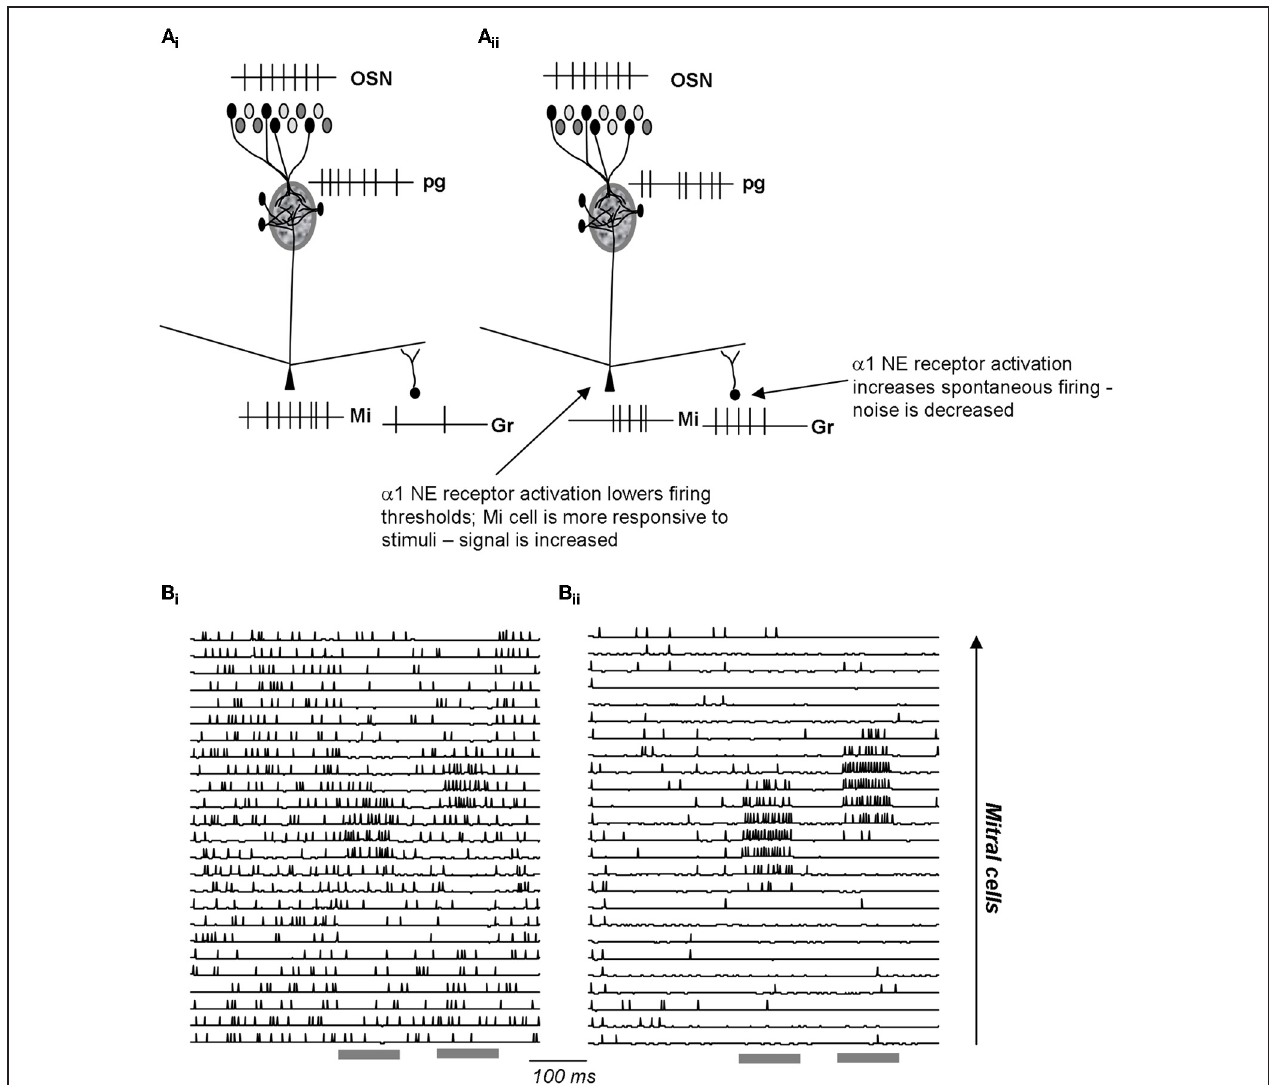
As a consequence, α 1 activation leads to increased signal-to-noise ratio.